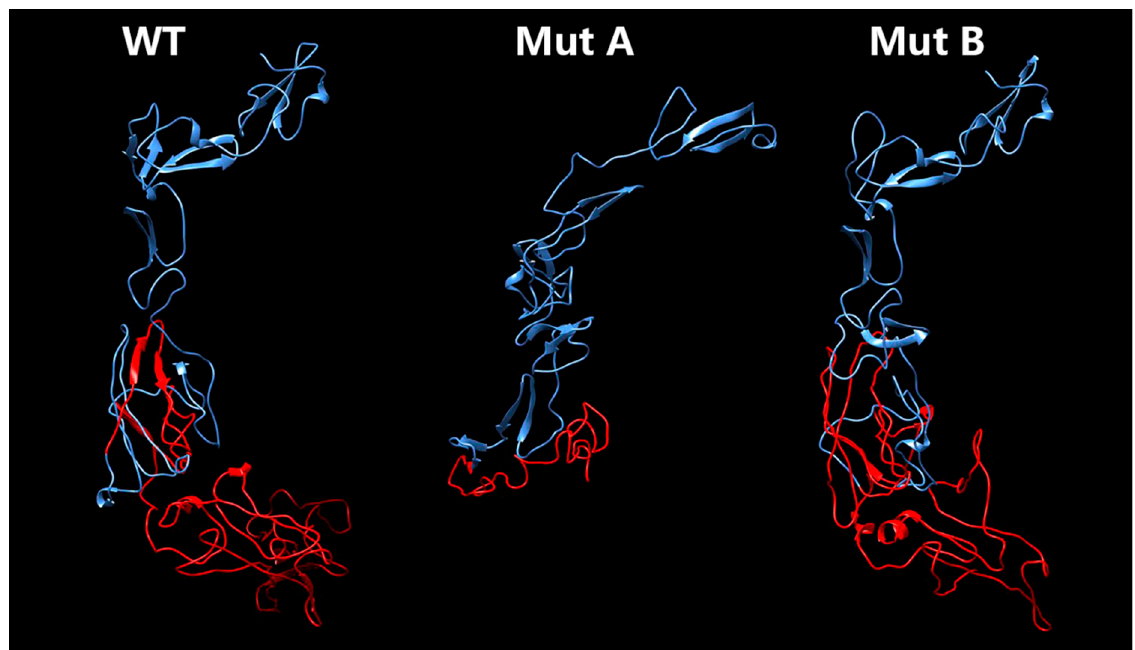
Figure 4. Protein structural modeling analysis of the wild-type and two mutant fibrillin-1 proteins. The amino acids before the mutation are indicated in blue. The amino acids after the mutation are indicated in red.